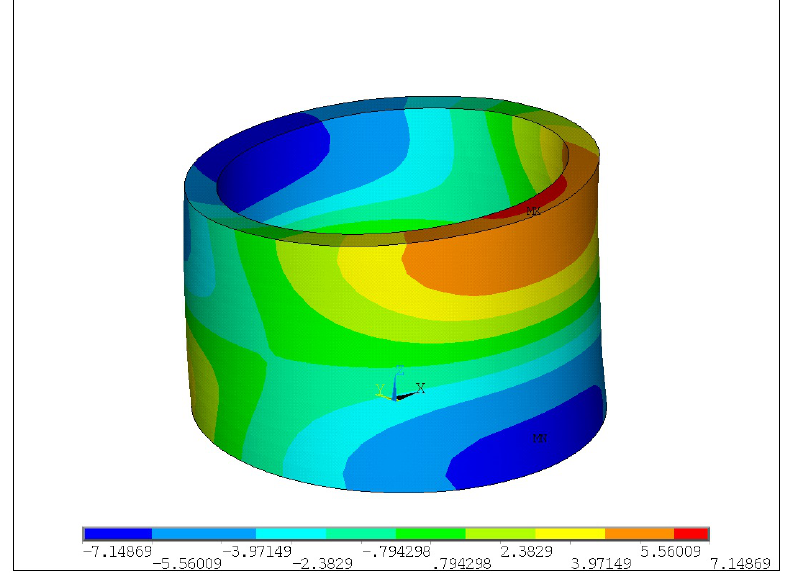
Figure 6. Modal analysis: The suitable eigenform at 88,371 Hz, deformations in Z direction. The proposed electrode configuration and the excitation of two electrodes with different voltages result in rotation of the sphere by two contact points. The contact point trajectory was calculated. The analysis shows that the contact point between electrodes 4 and 5 on XZ plane (Figure 1b) moves in ellipsis that has angle φ = deg 88 (angle φ describes rotation of ellipse on the plane). The contact points that are positioned in the middle of electrodes 4 and 5 produce elliptical motion as well, but the angles are φ = 74 ◦ and φ = 82 ◦ respectively. The movement of the second contact point (Figure 4b—node 10) is shown in Figure 7. The direction and angles of the contact points can be effectively controlled by changing the applied voltage. When electrodes 6, 7 or 8 are excited, the biggest deformations occur in the bottom nodes. These are used to move the actuator on the plane. Exciting the top and bottom electrodes at the same time results in both rotations of the sphere and movement of the